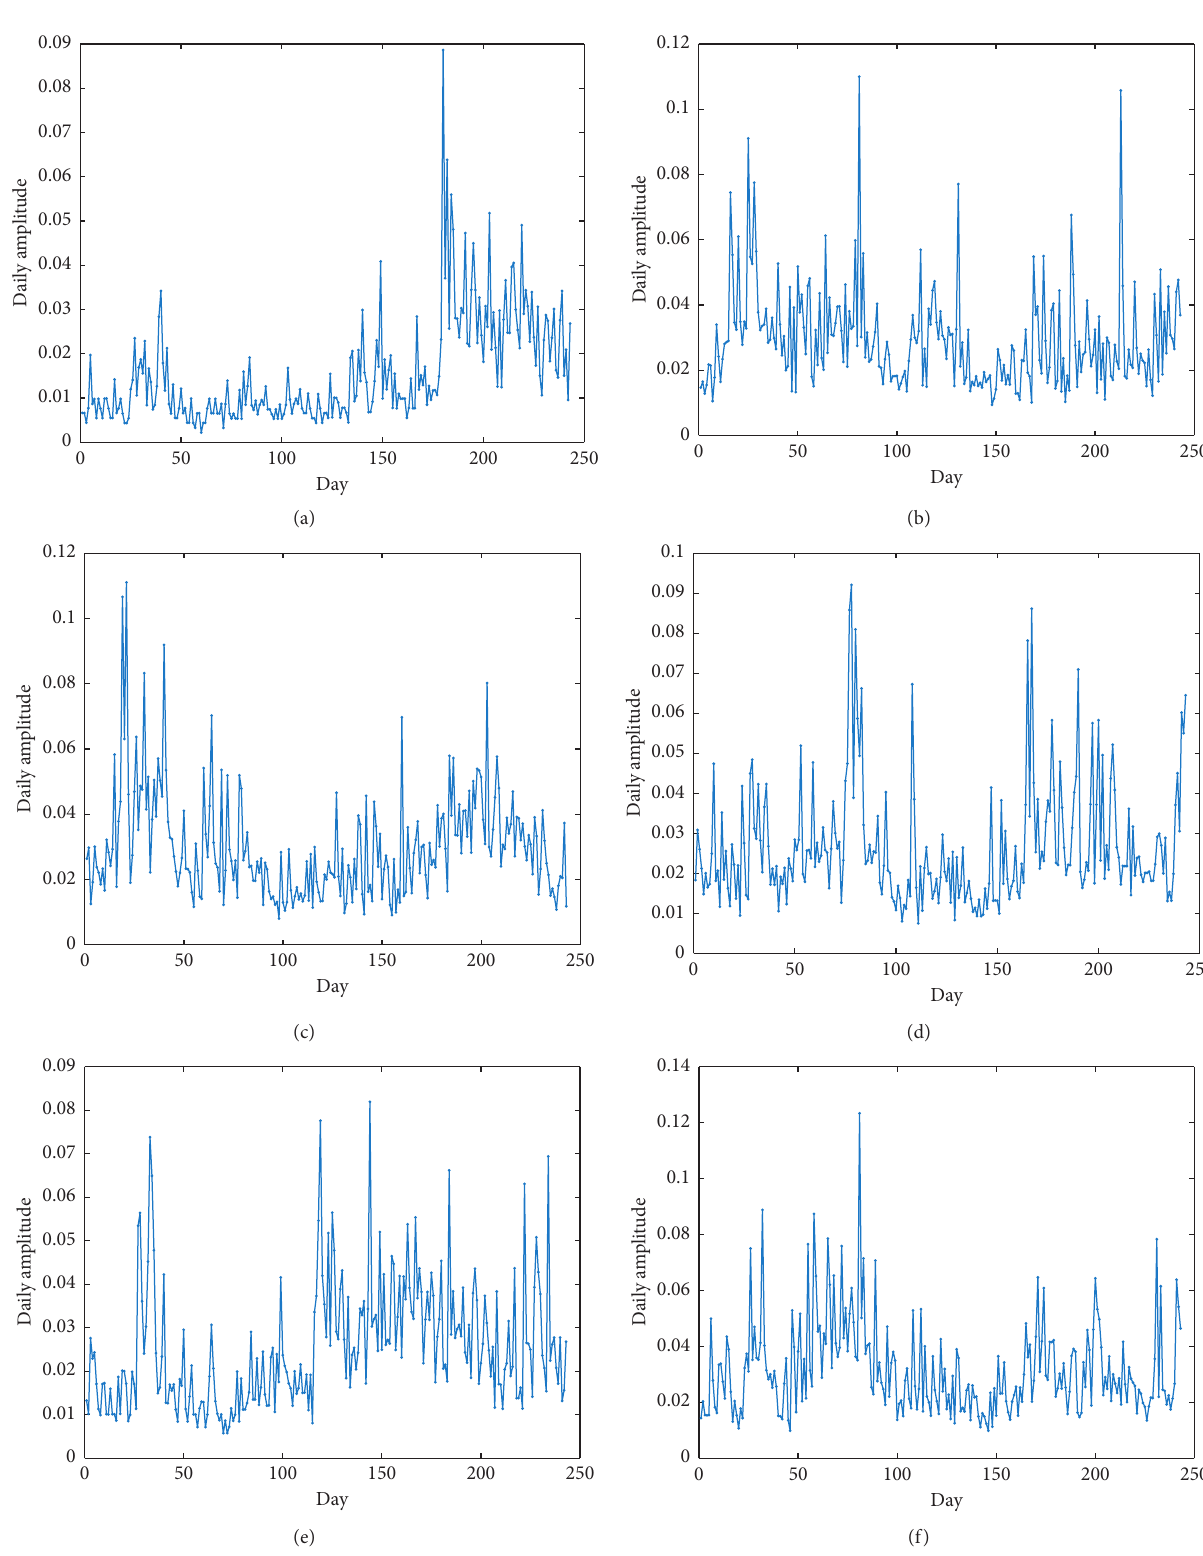
Figure 2: Display of daily amplitude of some stocks: (a) Ping An Bank during 2016-2017; (b) Ping An Bank during 2017-2018; (c) Shenzhen Zhongjin Lingnan Nonfemet during 2016-2017; (d) Shenzhen Zhongjin Lingnan Nonfemet during 2017-2018; (e) Overseas China Town A during 2016-2017; (f) Overseas China Town A during